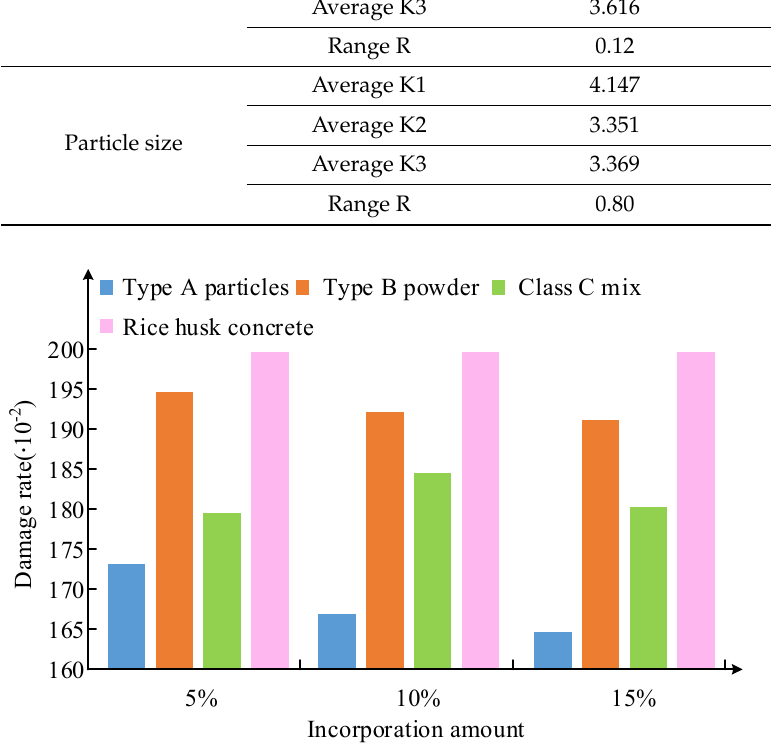
Figure 4. Comparison diagram of fatigue damage rate of concrete and rice husk concrete in this study.